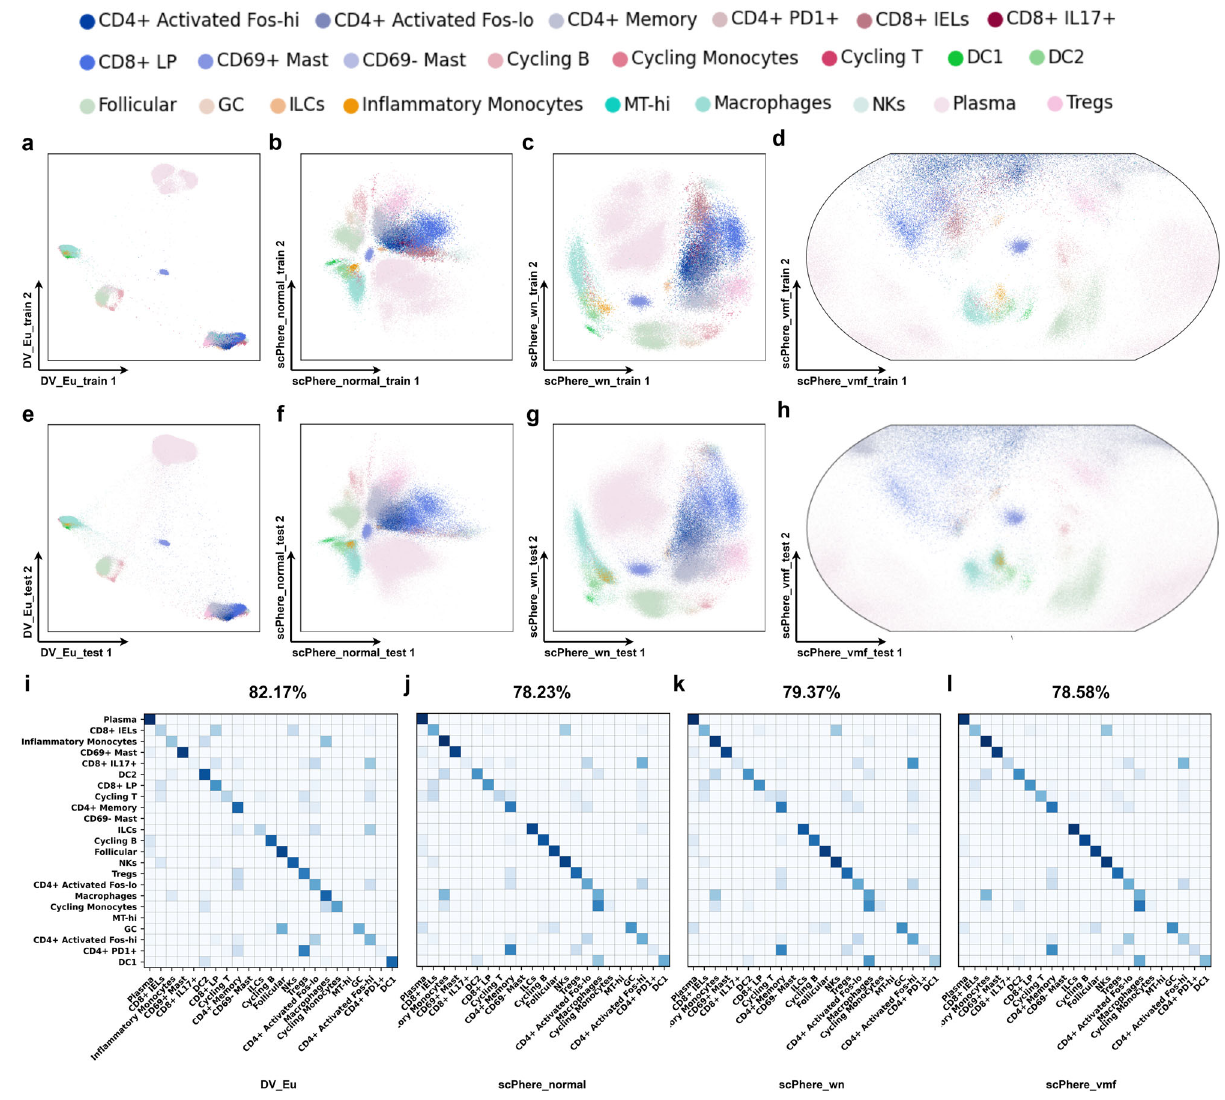
Fig. 6 Using learned DV model to visualize cells, pinpoint cell types impacted by biological factors, and generate a “ batch-invariant ” reference atlas. The “ batch-invariant ” DV model is trained on 18 UC immune patients ( a – d ) and tested on 12 UC immune patients ( e – h ). DV_Eu learns representations in the Euclidean space ( a , e ). 2-dimensional scPhere_normal ( b , f ), scPhere_wn ( c , g ) and scPhere_vmf ( d , h ) representations. Confusion matrices ( i – l ) of the overlap in cells (row-centered and scaled Z -score, color bar) between “ true ” cell types from the original study (rows) and cell assignments by k -NN classi fi cations ( k = 5) from “ batch-invariant ” DV model is trained on training set cells for immune cells (SCP259). CD69- mast cells and MThi cells are observed in the training data